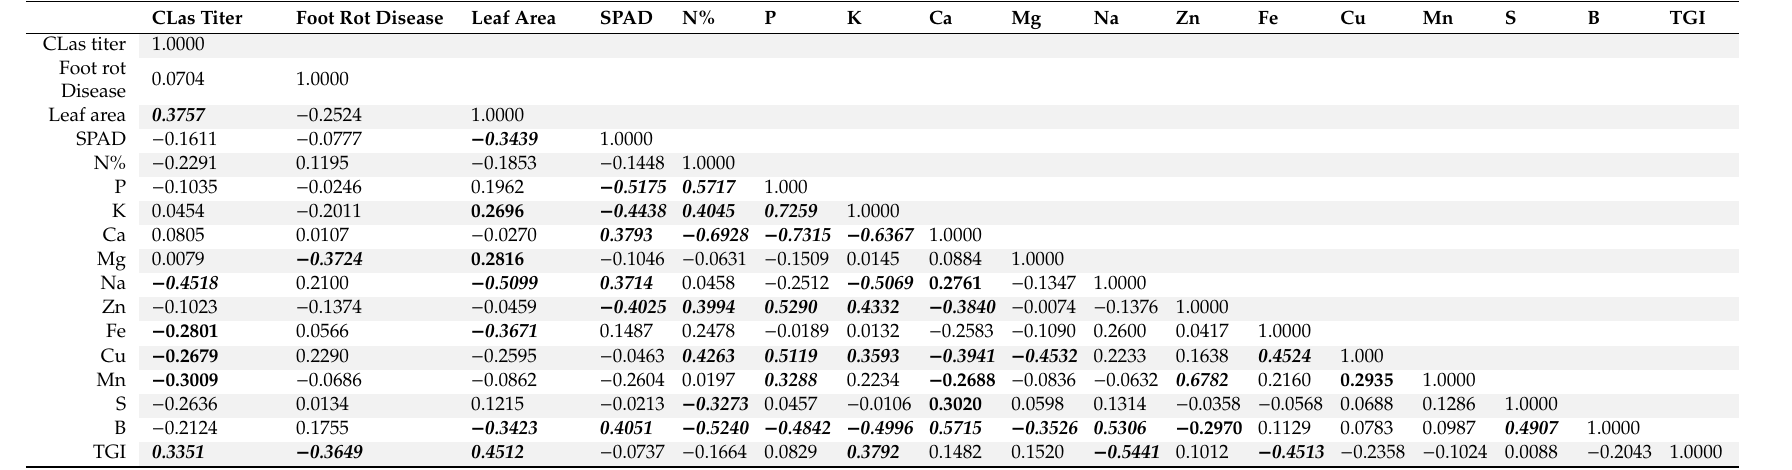
Table 2. Correlation of measured physiological, disease, and extrapolated factors. The significant correlations are shown in italics, bold, or italics and bold numbers with increasing significance. Positive values indicate positive relationships while the negative values indicate negative relationships between